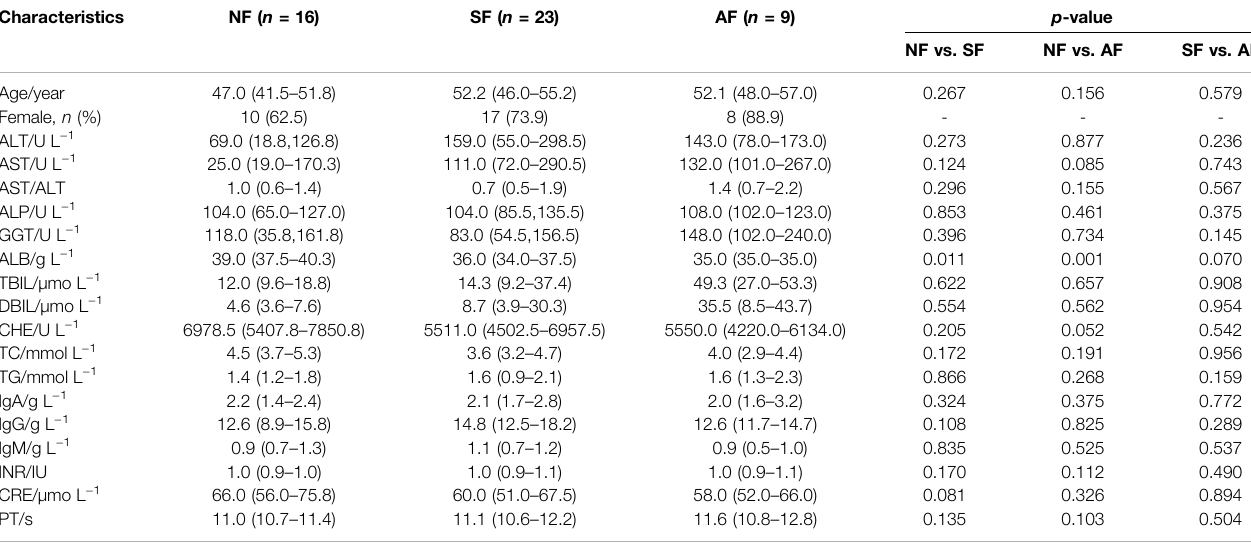
TABLE 1 | Clinical characteristics of the study patients in NF, SF, and AF groups.